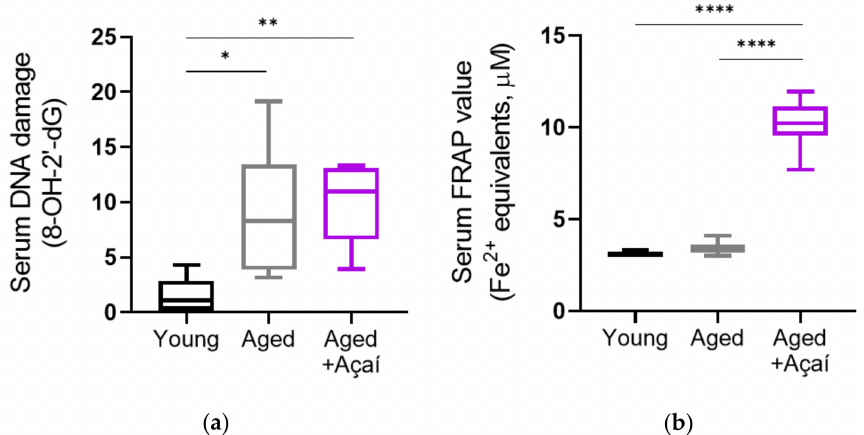
Figure 3. Systemic evidence of an altered redox state. ( a ) Levels of the DNA oxidative damage marker 8-OH-2 (cid:48) -dG in the serum from non-pregnant female mice (n = 6 young, 8 aged, 8 aged+ aça í ). ( b ) Ferric reducing antioxidant power (FRAP) values indicative of the total antioxidant power in the serum from non-pregnant female mice (n = 6 young, 9 aged, 9 aged+ aça í ). The data were compared using ordinary one-way ANOVA with Tukey’s multiple comparisons when the overall effect p < 0.05. * p < 0.05, ** p < 0.01, **** p <